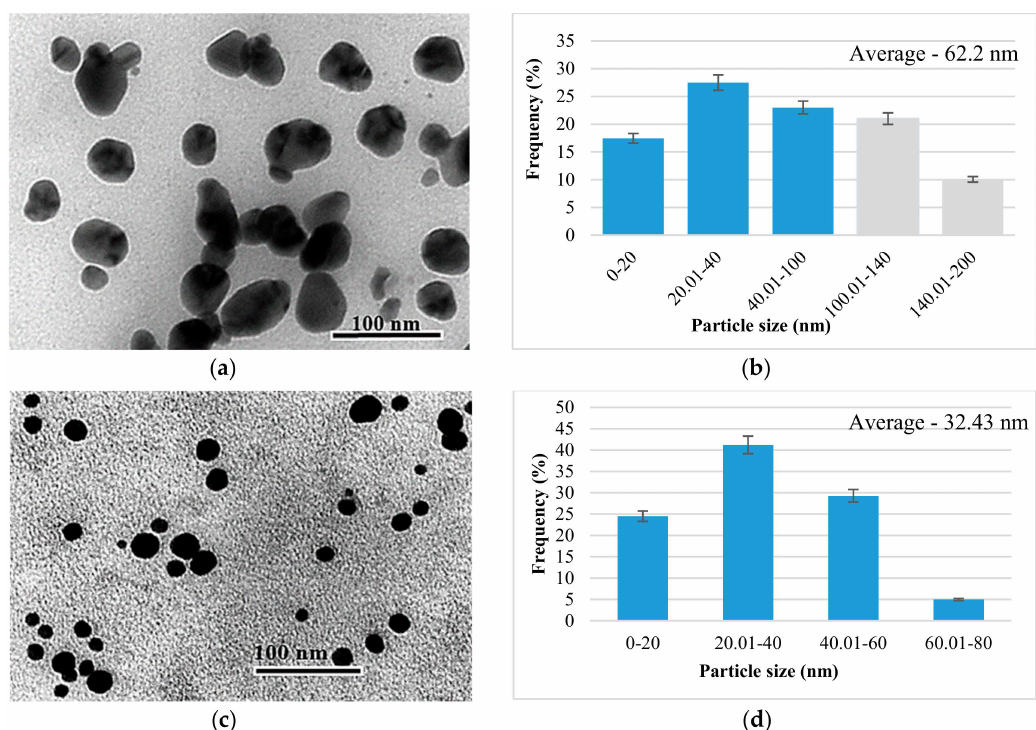
Figure 6. Graphical representation of AgNP synthesized in the presence of the extract obtained from the beech bark and AgNO 3 : ( a ) TS1— TEM photomicrograph; ( b ) histogram of the distribution of the AgNP size distribution in the TS1; ( c ) TS2—TEM image; ( d ) histogram of the distribution of AgNP